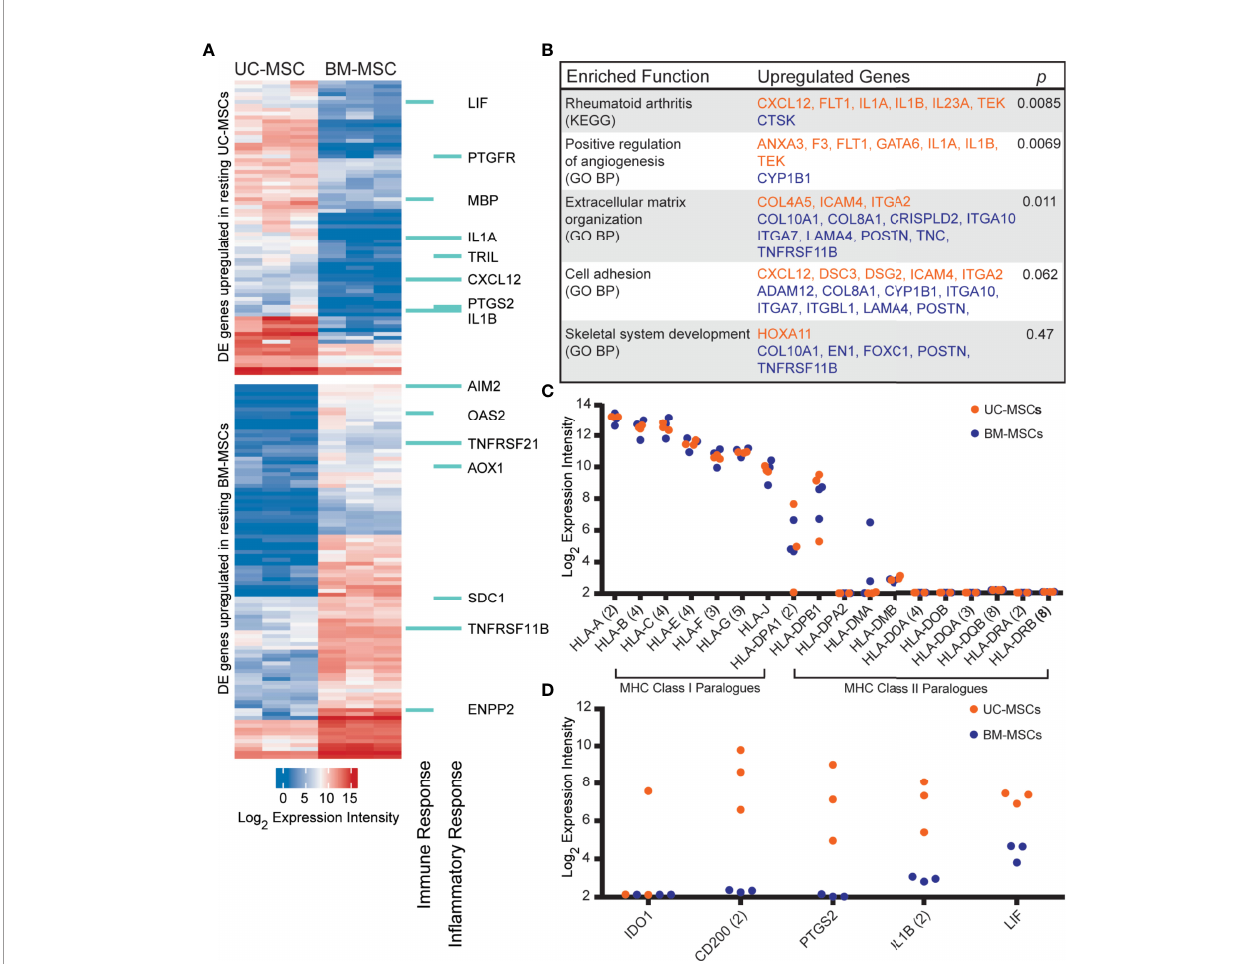
FIGURE 1 | The transcriptomes of unstimulated UC and BM-MSCs exhibit signi fi cant differences. (A) Seventy-six genes are preferentially expressed by UC-MSCs, while 98 genes are enriched in BM-MSCs. A subset are components of immune and in fl ammatory responses, as speci fi ed by GO. (B) Few DE genes exhibit functional co-registration. Genes DE by UC (orange) and BM (purple) MSCs contribute to few enriched (p<0.05) functional annotations. (C) UC and BM-MSCs similarly express MHC-I paralogues and lack most MHC-II paralogues. (D) Key immunomodulatory genes are more highly expressed in resting UC-MSCs. BM, bone marrow; DE, differentially expressed; GO BP, Gene Ontology Biological Process annotation; KEGG, Kyoto Encyclopedia of Genes and Genomes pathway annotation; MSC, mesenchymal stromal cell; UC, umbilical